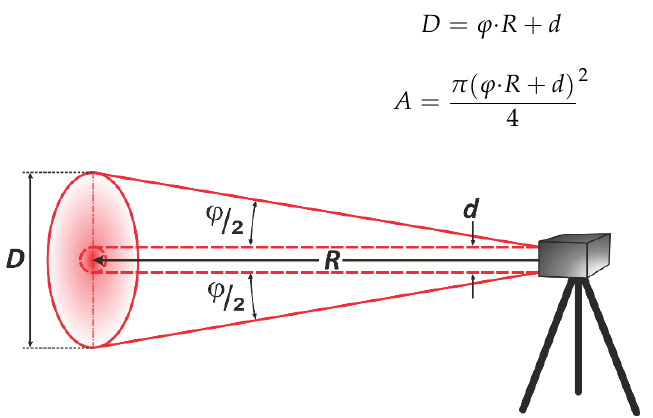
Figure 4. Footprint created by a laser